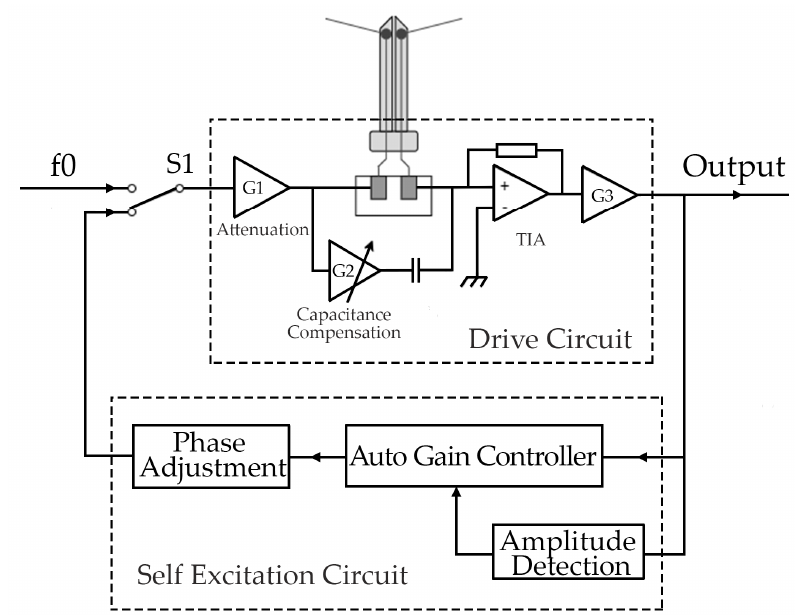
Figure 9. Schematic diagram of the self-excitation drive of the QTF self-induction probe.